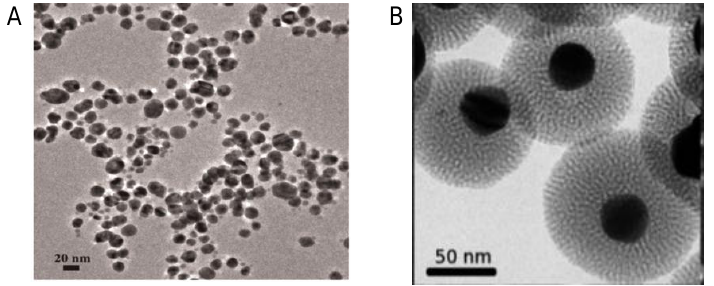
Figure 3. TEM image of different AgNPs. ( A ) AgNPs; ( B ) Mesoporous silica-coated silver nanoparticles (Ag@MSN) coated on a silicon substrate.